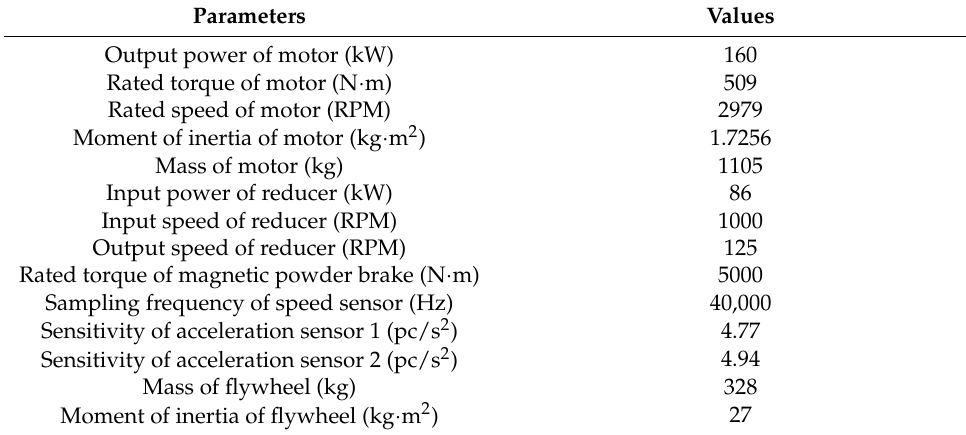
Table 4. Parameters of the test rig.